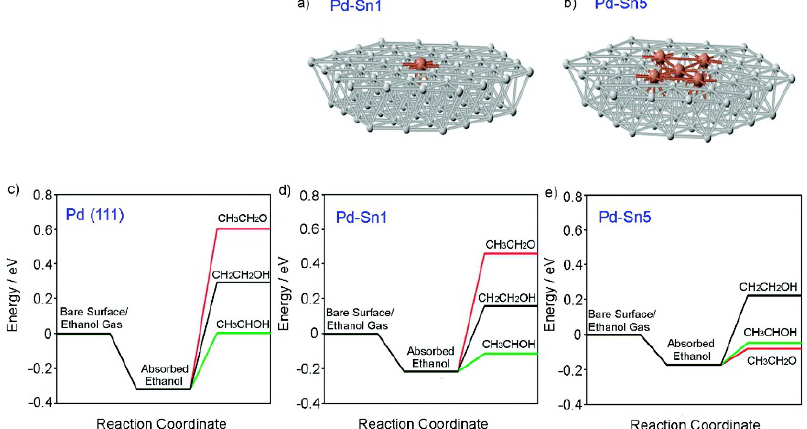
Figure 11. Surface cluster models of ( a ) Pd–Sn 1 and ( b ) Pd–Sn 5 used for modeling ethanol dehydrogenation, and reaction energies for H removal from ethanol over ( c ) Pd (111); ( d ) Pd–Sn 1 , ( e ) Pd–Sn 5 surfaces. Reproduced with permission from Reference